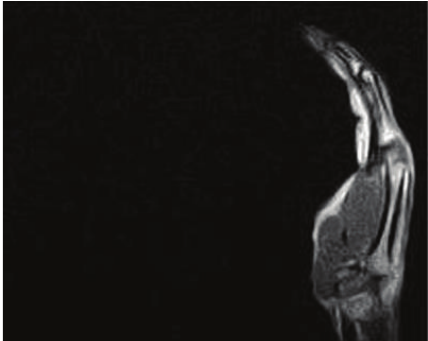
Figure 4: MR image of the volunteer without RFID tag attached to the wrist (imaging sequence: T 2 —Fast spin echo Sagittal).